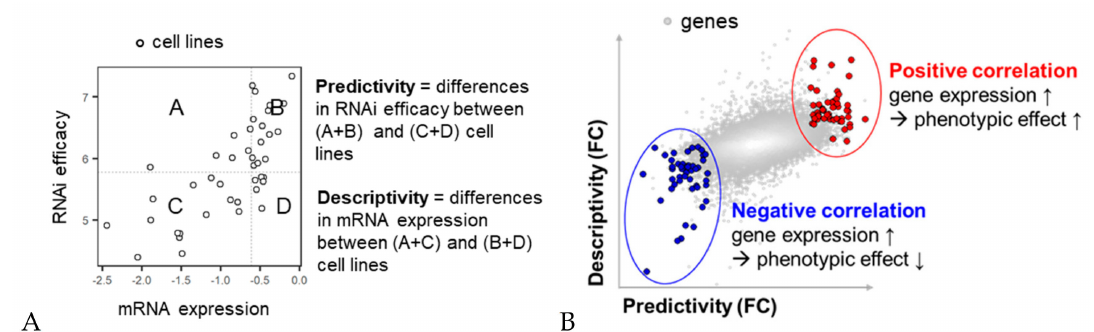
Figure 3. Schematic description of the bidirectional calculation method for the association between mRNA expression and RNAi e ffi cacy for a given gene in the cell line panel. ( A ) Distribution of cell lines by mRNA expression vs. RNA i e ffi cacy for a given gene. Predictivity and descriptivity were calculated after cell lines were grouped based on median mRNA expression levels and RNA i e ffi cacy. ( B ) An example plot of the predictivity and descriptivity scores of over 12,000 genes derived from the calculation method in ( A ). Colored circles represent genes with statistical significance ( p -value < 0.01) for both predictivity and